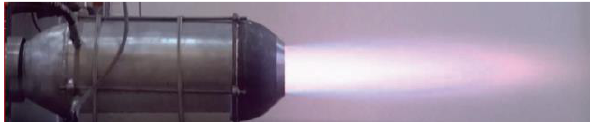
Fig. 11. Test of the rocket-ramjet engine at the experimental test stand at Łukasiewicz – Institute of Aviation